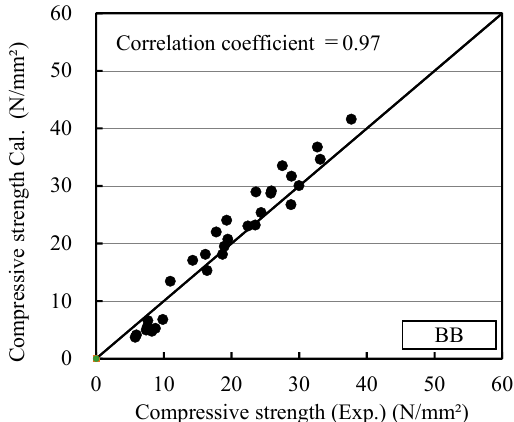
Figure 12. Measured compressive strength and calculated compressive strength (BB): Proposal equation for this study.